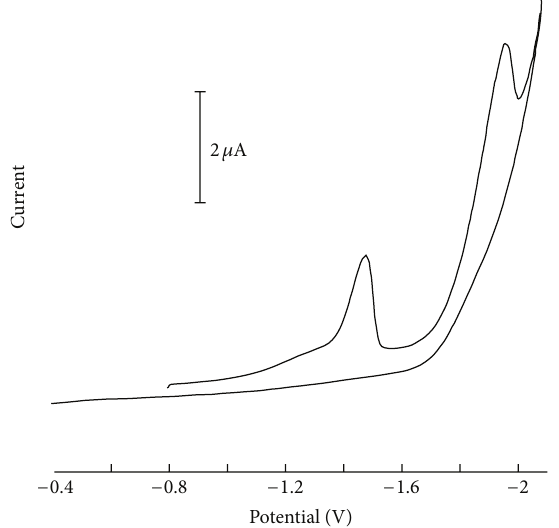
Figure 2: Staircase cyclic voltammograms for 1.7 × 10 −6 molL −1 of Ni(II)-salen complex in phosphate buffer (0.02 molL −1 , pH 7.0). Equilibrium time: 30 s at − 800 mV. Scan rate: 300mV ⋅ s −1